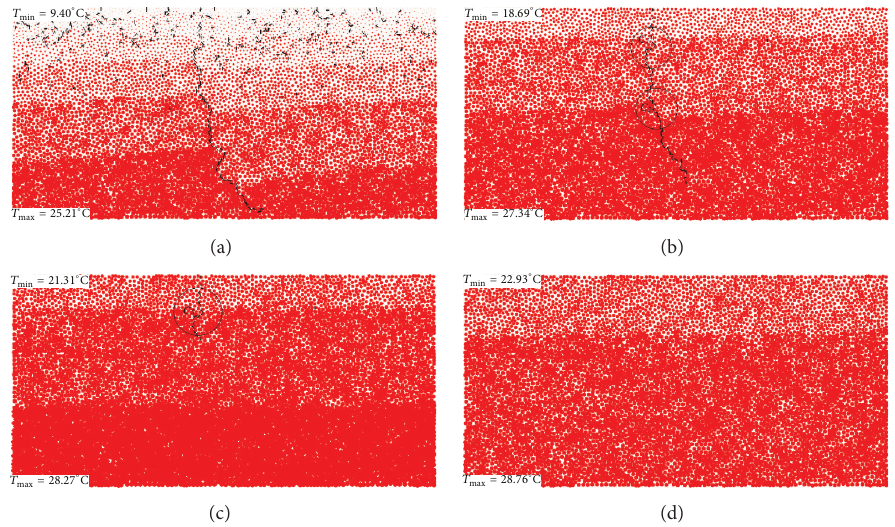
Figure 13: Influence of thermal cracks on thermal fields: (a) Case 1, (b) Case 2, (c) Case 3, and (d) Case